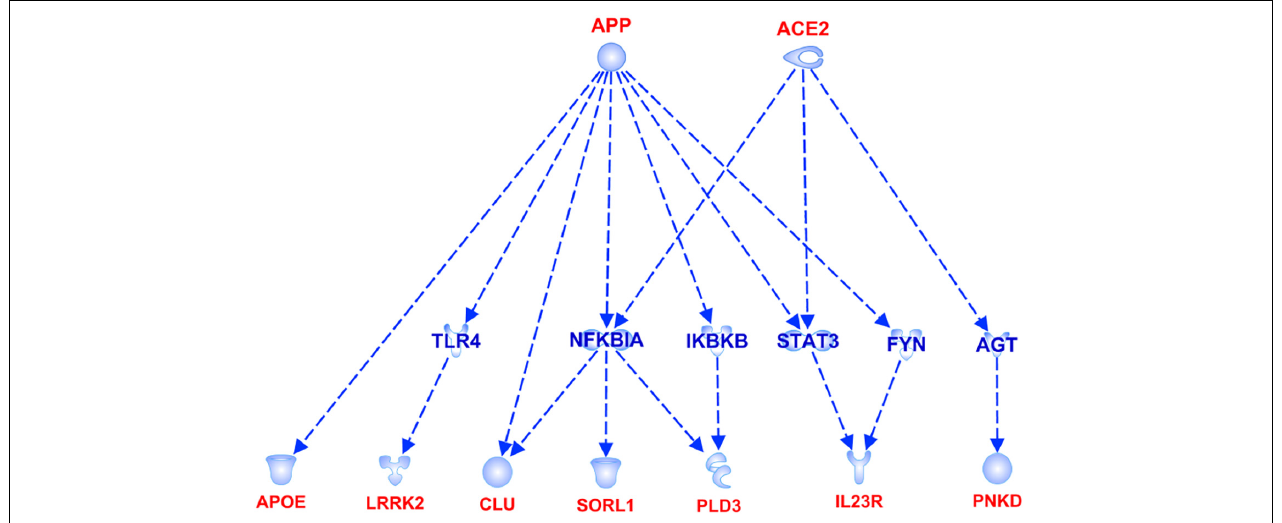
FIGURE 6 | APP and ACE2 signaling pathways showing the interaction with the genes associated with